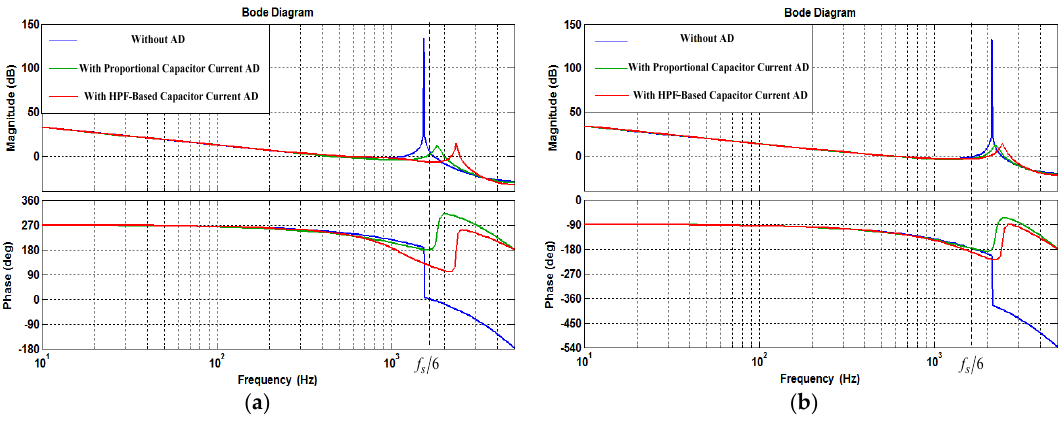
Figure 20. Bode plots showing open-loop gain of grid-side current control with and without AD schemes: ( a ) low frequency region ( L g = 4.8 mH, f res = 1.521 kHz, K P = 0.09, K D = 0.041 (green diagram), K D = 0.115 (red diagram)); and ( b ) high resonant frequency ( L g = 0 mH, f res = 2.119 kHz, K P = 0.06, K D = 0.02 (green diagram), K D = 0.055 (red diagram)).